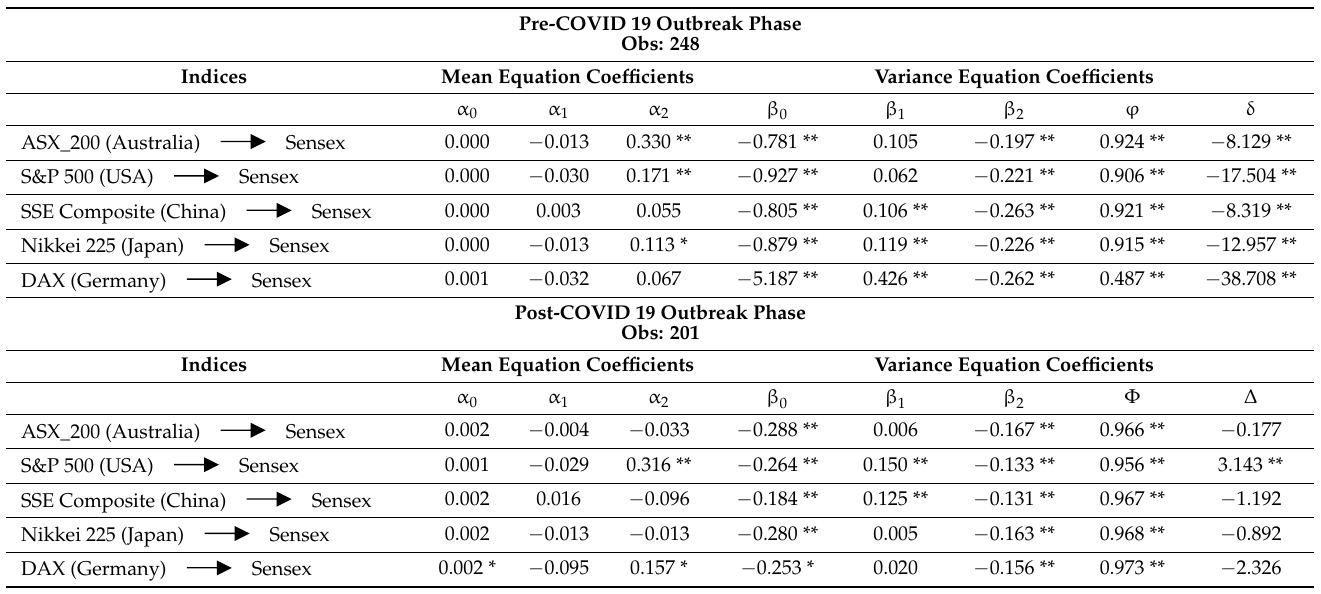
Table 6. Volatility spillover from foreign markets to Indian market.